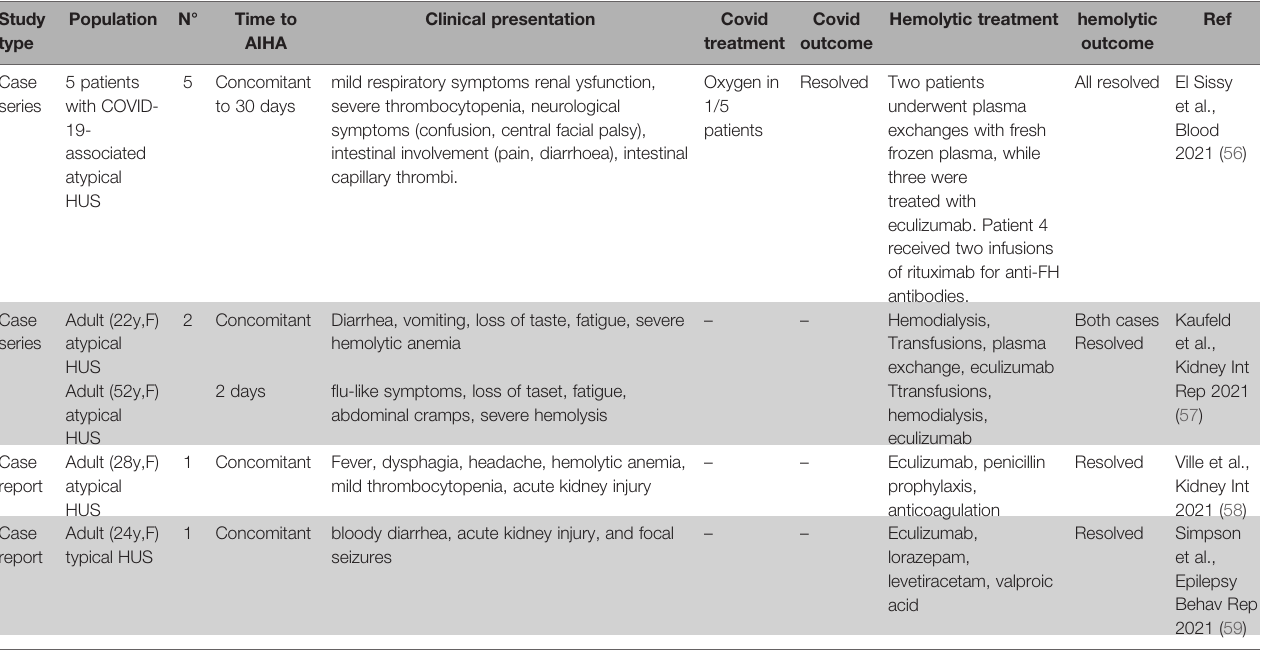
TABLE 5 | Hemolytic fl ares in patients with hemolytic uremic syndrome (HUS) during COVID-19